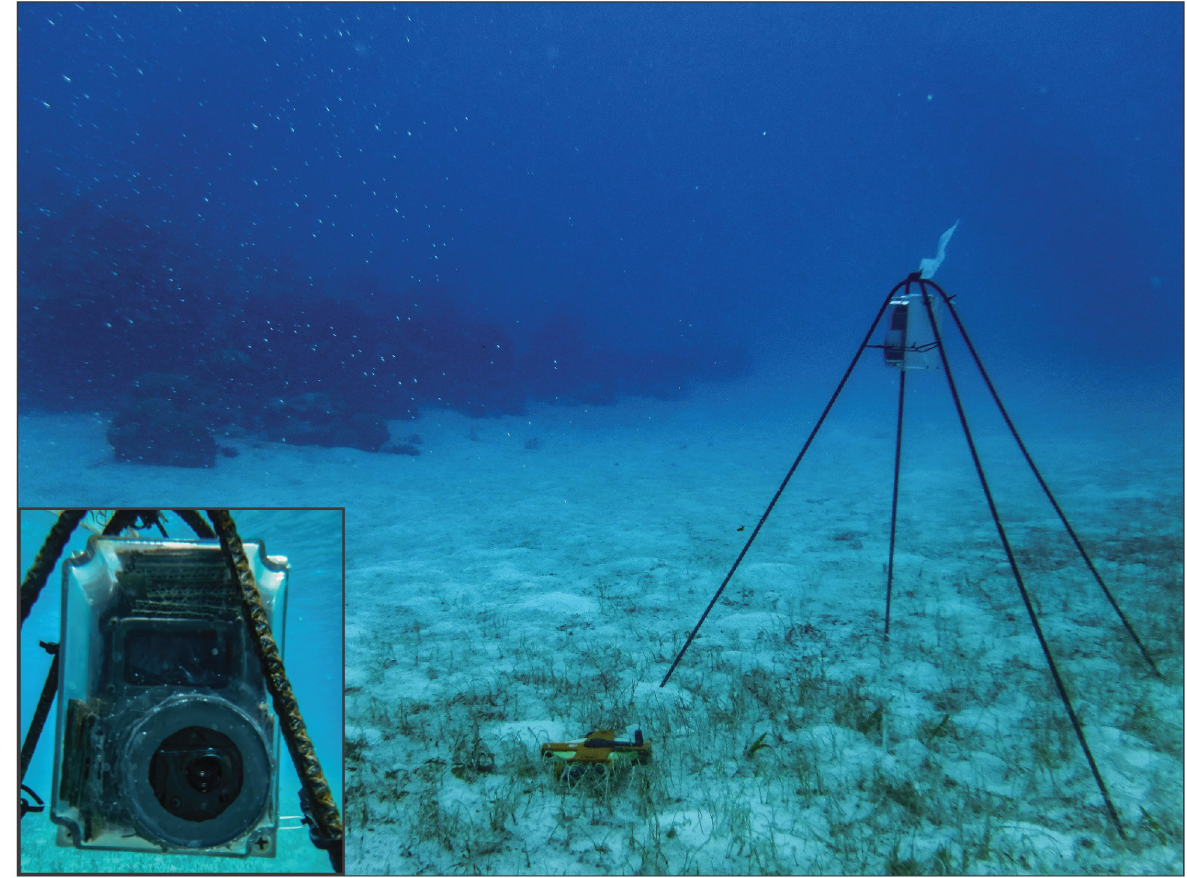
Fig 1. DEACs deployed on four-legged rebar stands in the field. Plastic cable ties attached to the camera housing and to the legs were used to secure buoyant cameras in housings below the crossed rebar at the top of each stand. Bottom left inset: A detailed front view of a camera in Housing 1 underwater. Reprinted from [39] under a CC BY license with